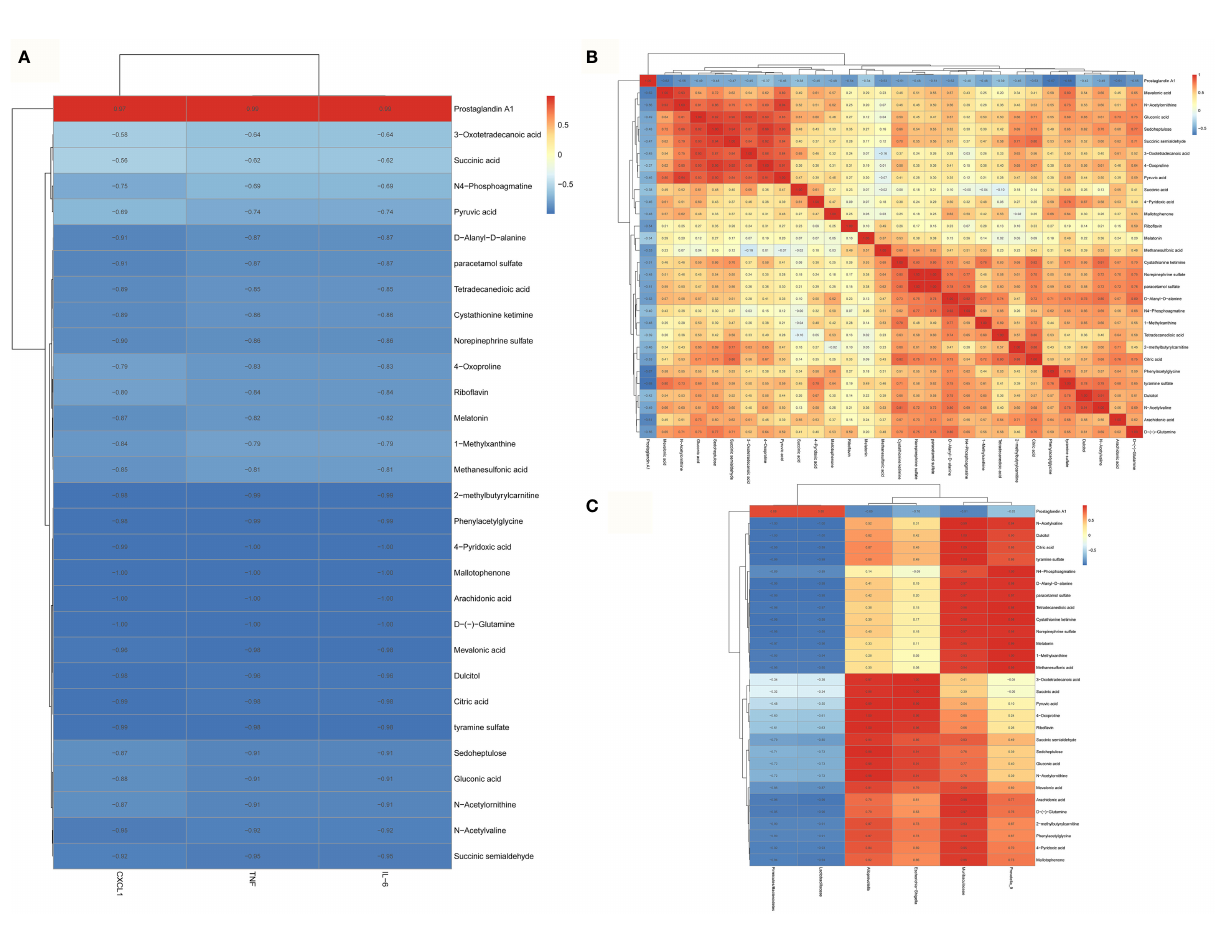
FIGURE 6 | The correlation analysis of the gut microbial metabolites, gut microbiota and brain in fl ammation in septic rats. (A) A correlation analysis showed 21 positive and 29 negative correlations among the microbial metabolites. (B) only prostaglandin A1 correlated positively with the in fl ammatory factors and chemokines such as TNF, IL-6, and CXCL1 of the brain. TNF:TNF- a (C) The correlation analysis between gut microbiota and its metabolites showed a positive correlation of Firmicutes / Bacteroidetes , whereas Lactobacillaceae showed a positive correlation with prostaglandin A1 and a negative correlation with the remaining 29